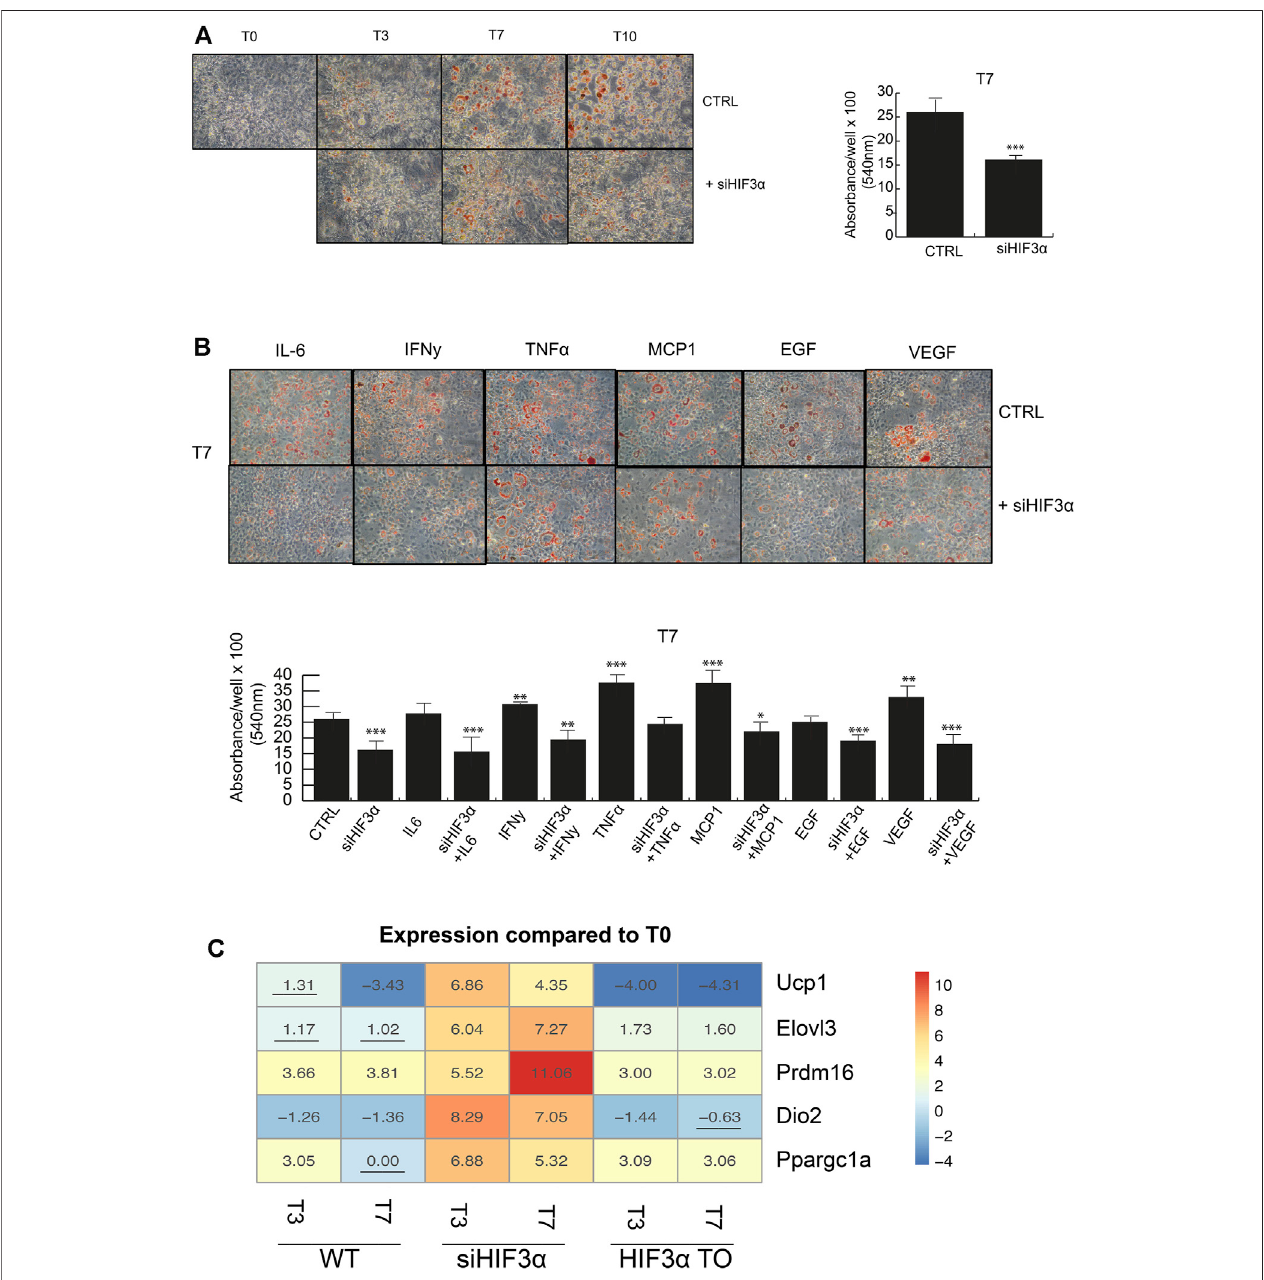
FIGURE 2 | Hif3 α inhibition redirects adipocyte differentiation toward BAT phenotype (A,B) 3T3-L1 cells were plated and transfected with si Hif3 α , and exposed to pro-in fl ammatory cytokines and differentiation medium until the appearance of mature adipocytes (T0 to T10). Representative Oil Red O-staining by light microscopy in our experimental condition. Quanti fi cation of Oil Red O-staining at 540 nm ( n (cid:2) 3) using a TECAN robotic station in mature adipocytes at day 7. *** p ≤ 0.001, ** p ≤ 0.01, * p ≤ 0.05 vs . control. (C) Analysis of BAT gene regulation ( Ucp1, Elovl3, Prdm16, Dio2, Ppargc1a ) in WT, si Hif3 α and HIF3A TO adipocytes. Heatmap represents expression pro fi le of BAT genes differentially expressed across the different experimental conditions. Values represent the means of the fold change vs. T0WT ( n (cid:2) 3). T0WT is calculated as 1, thus > 1 means upregulation, < 1 means downregulation. All values are signi fi cant ( p ≤ 0.01) except those underlined.